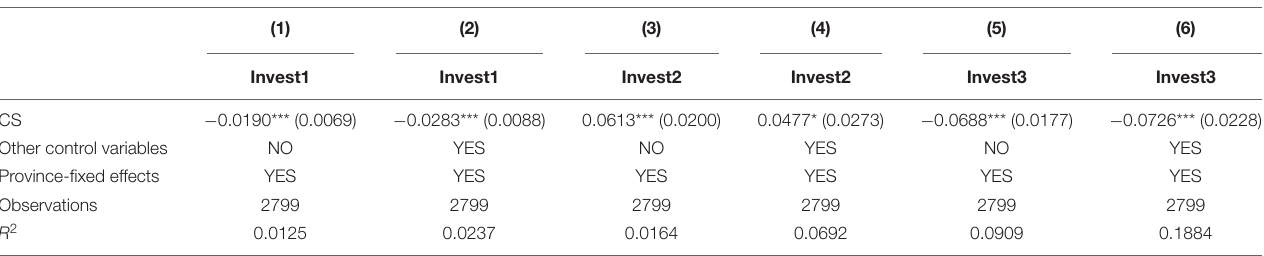
TABLE 5 | Robustness test 1: Bilateral truncation on the 1% quantile of the climate shock